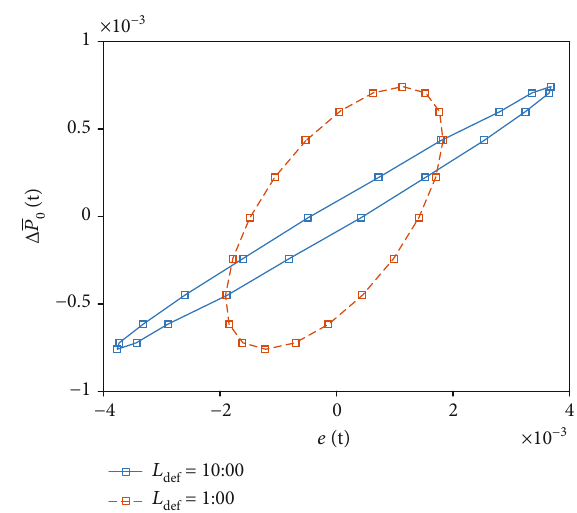
Figure 14: In fl uence of L on mechanical-hysteresis behavior at def j = 0 : 2600 , ϵ = 0 : 1750 , and f = 0 : 02 where e ð t Þ ( x conditions j (cid:1) ρ 0 (cid:1) ð t Þ ( y -axis) is the -axis) is the strain response at time t and Δ P 0 pressure input at time t established by the PCD